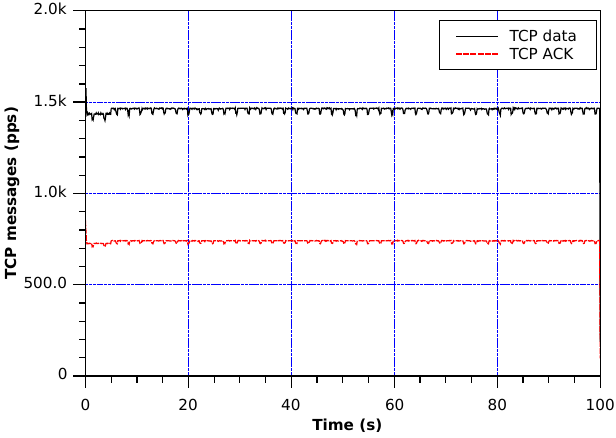
Figure 5. TCP data and acknowledgment packet rate on router without ACK rate limiting.